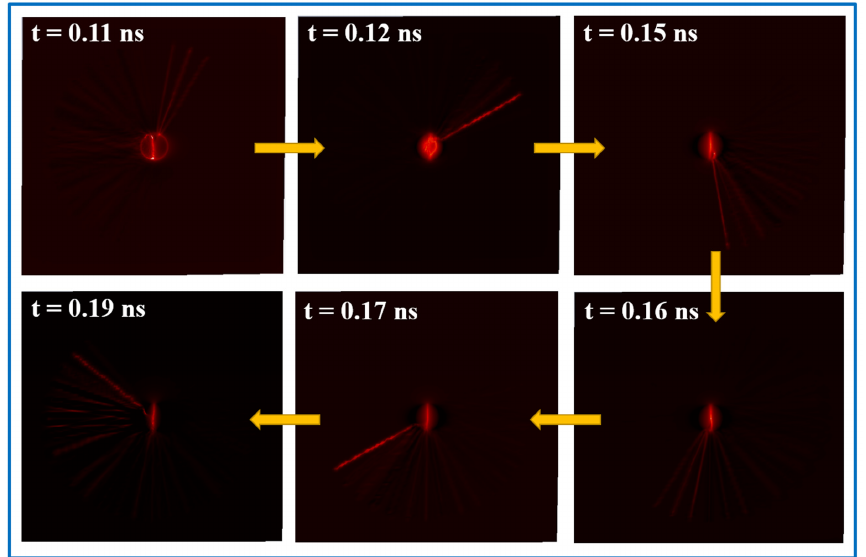
Figure 7. Dynamic electric field distribution of one rotating arm at different time steps. In this example, the corresponding rotating frequency is 10 GHz.